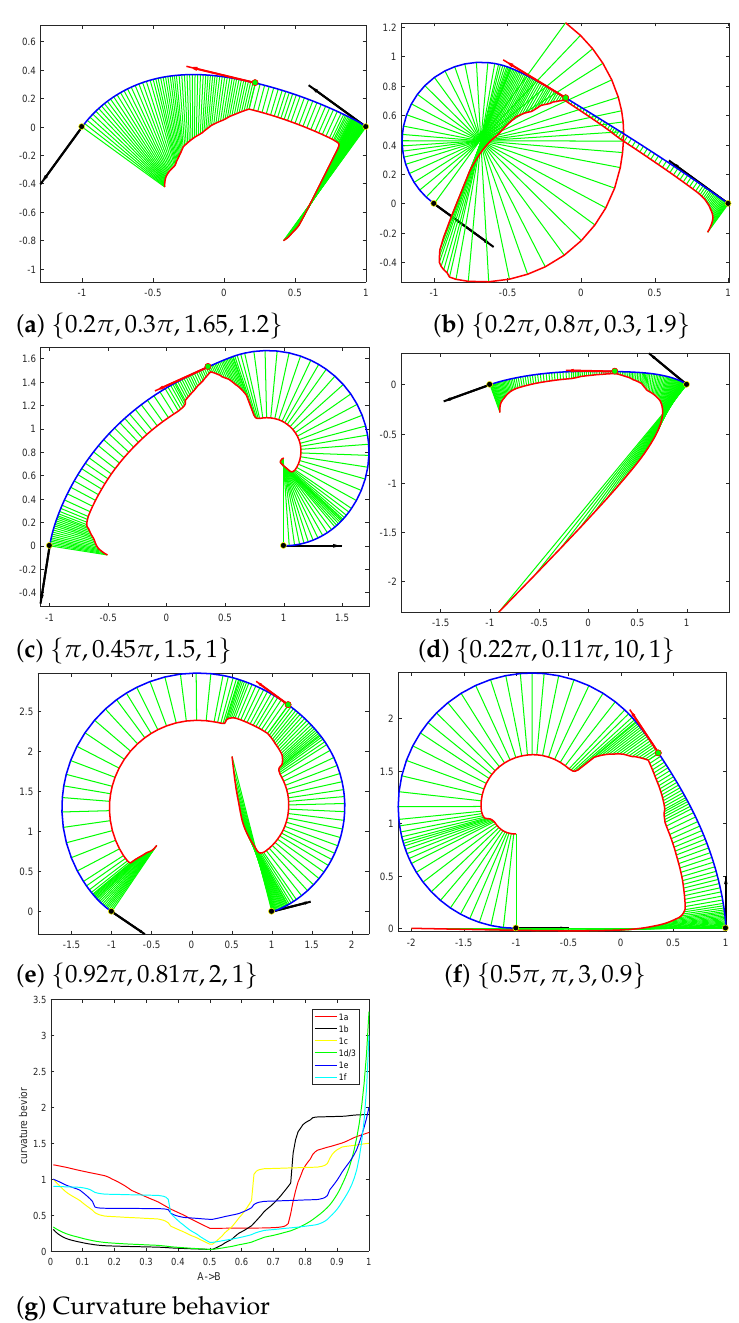
Figure 13. Example 1. Two piecewise spirals interpolating nonspiral